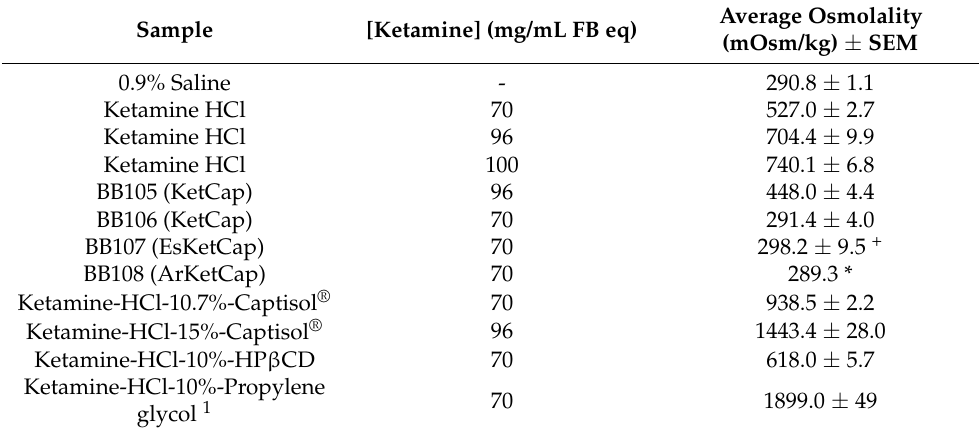
Table 1. Average osmolality of Ketamine HCl with and without additives and Ketamine Captisol ®